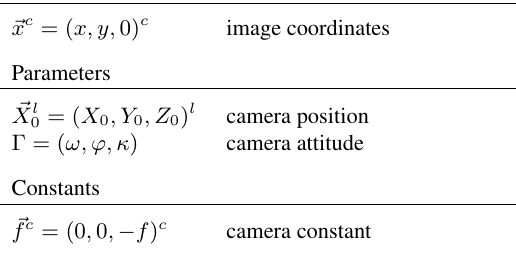
Table 2: Symbols in the ALS plane observation equation.